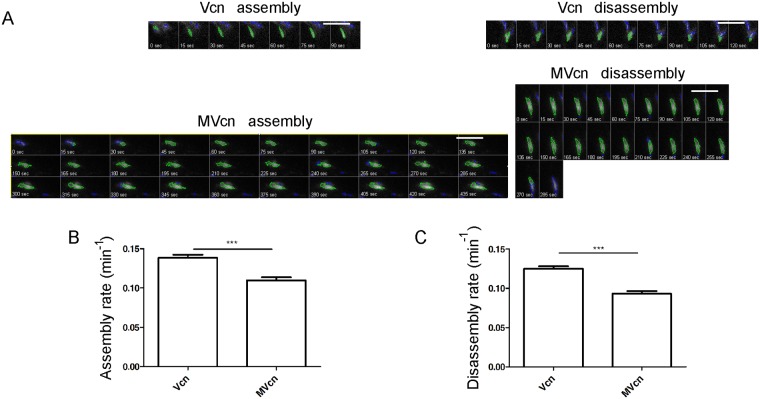
Focal adhesion assembly and disassembly rates are higher for Vcn-expressing cells compared to MVcn-expressing cells.(A) Representative time-lapse image sequences of Vcn-null MEFs stably expressing either mEmerald-Vcn or mRFP-MVcn migrating on 10 μg/ml FN. Images (shown in grayscale) are taken every 15 sec. Green outlines (generated by focal adhesion analysis program) show individual FA. Scale bar = 10 μm. Graph of average rate constants of FA assembly (B) and disassembly (C) from FAs in each cell type. Data pooled from 3 independent experiments (n ≥ 13 cells (and at least 400 adhesions); ***, p<0.001).